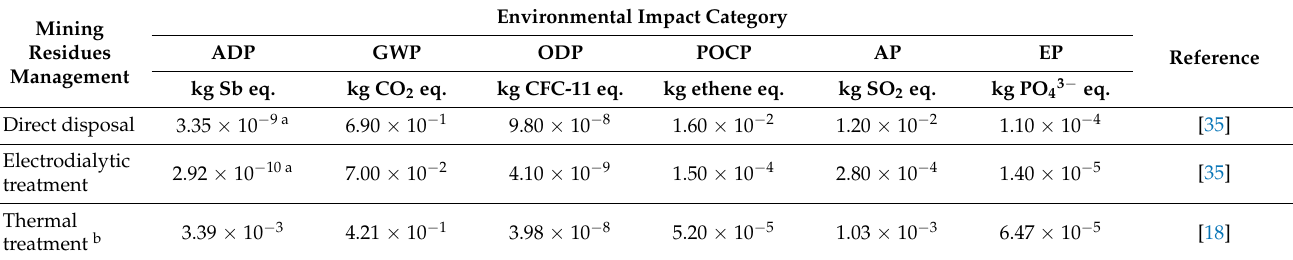
Table 3. Environmental impacts of the direct disposal, the electrodialytic treatment, and the thermal treatment of 1 kg of mining residues.